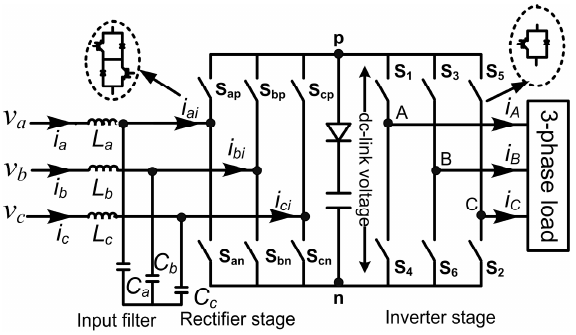
Figure 1. The indirect matrix converter (IMC) topology.